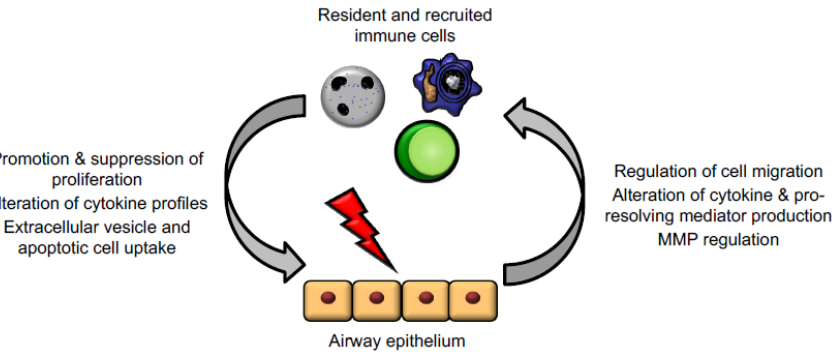
Figure 3. Epithelial cells and immune cells engage bidirectional communication to regulate tissue repair. Activated immune cells, including macrophages, neutrophils, and T lymphocytes, regulate epithelial cell responses to promote proliferation, alteration of mediator and cytokine production, and downstream signalling cascades. In turn, injured epithelium can themselves regulate immune cell trafficking and promote a shift from inflammation to resolution and repair functions.